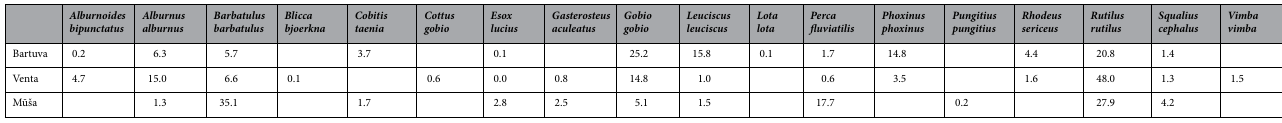
Table 4. Fish species composition and relative abundance per whole sampled area in the studied rivers stretches below HPPs.